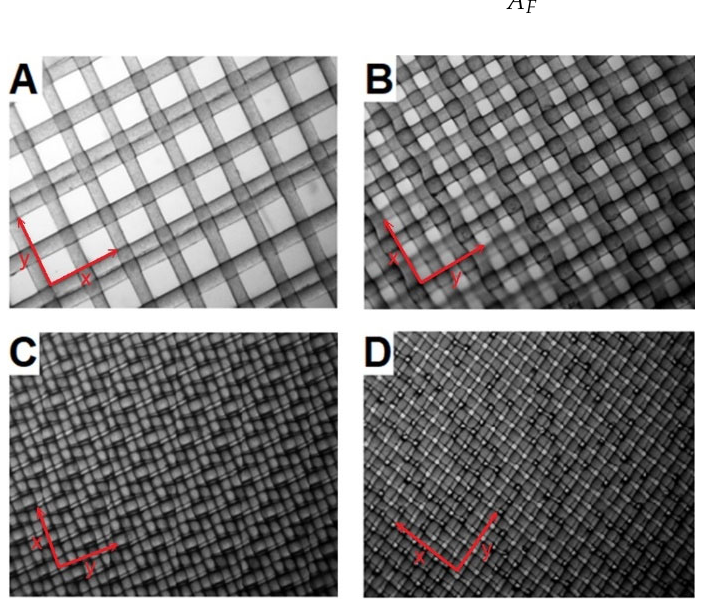
Figure 11. Hydrophilic filters with mesh sizes of 118 µ m ( A ); 63 µ m ( B ); 1 µ m ( C ); and hydrophobic 9 µ m filter ( D ) at 200 × magnification.